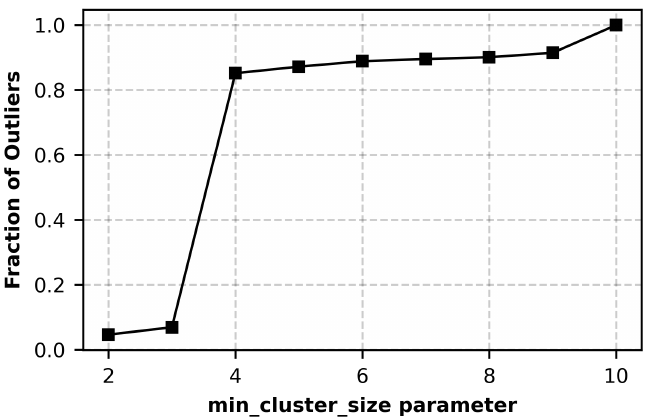
Figure 4. Sensitivity of percent outliers to the minimum cluster size